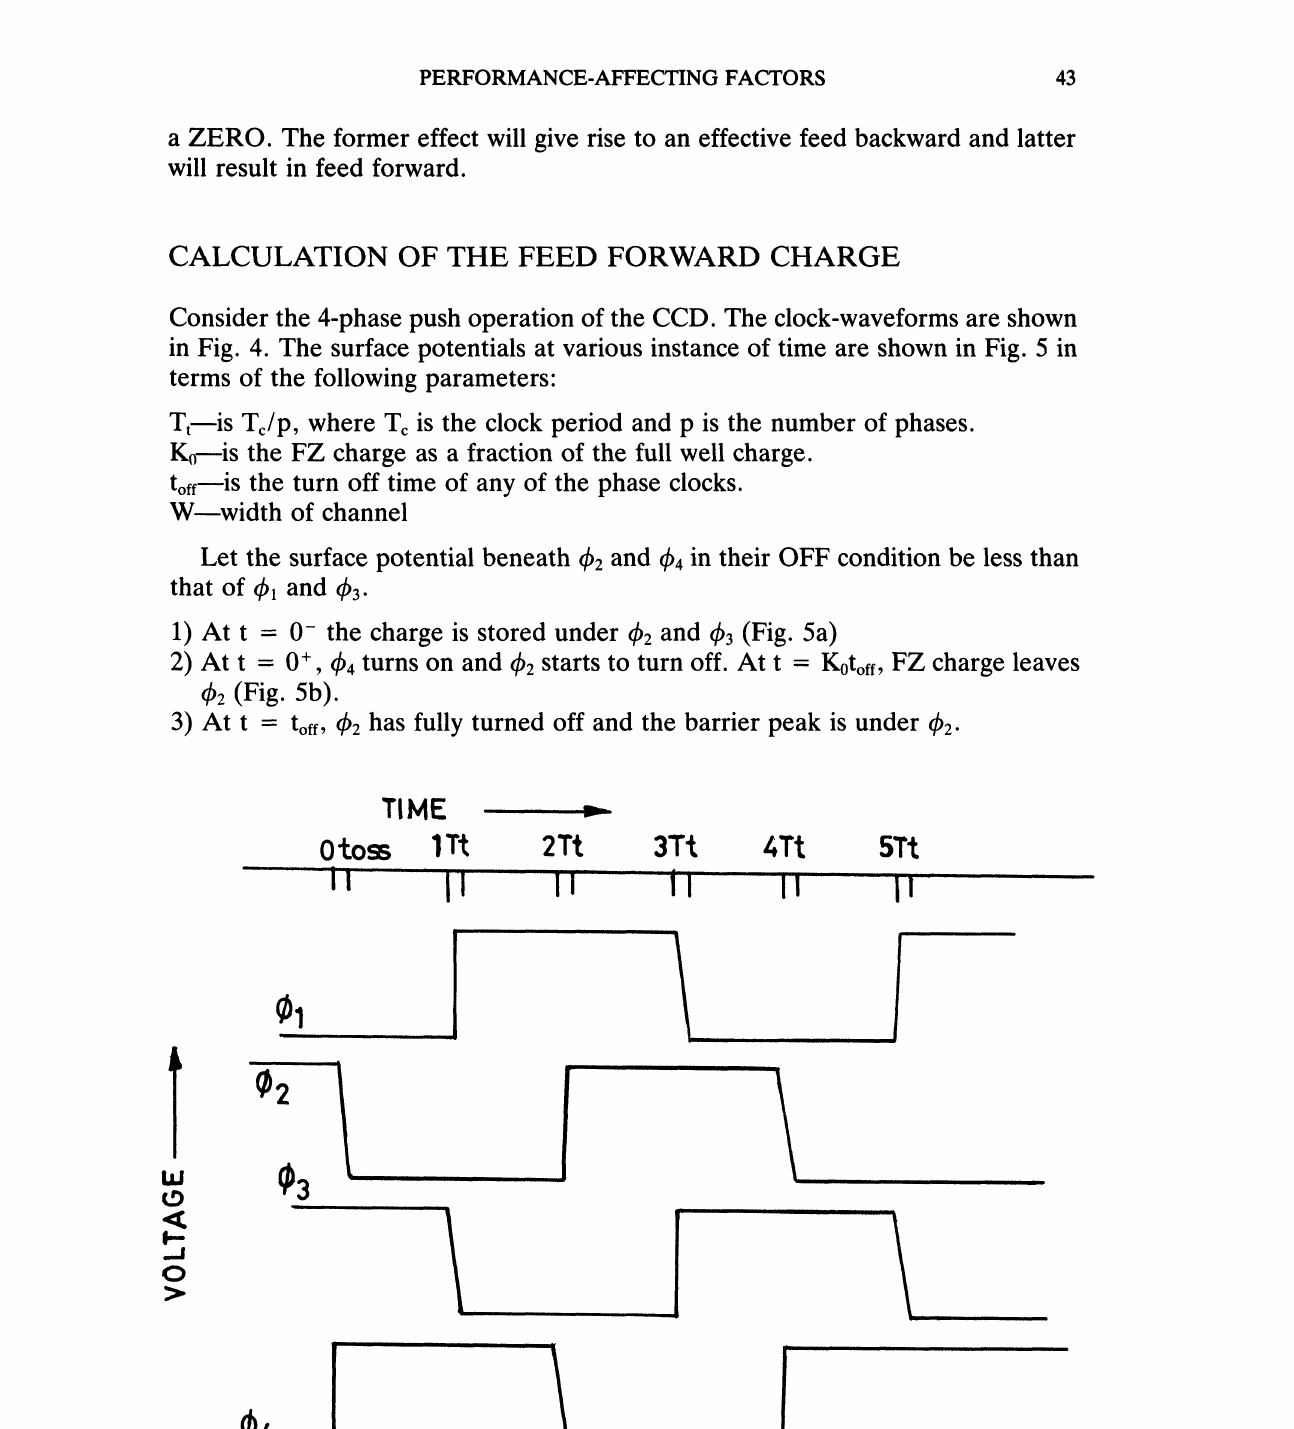
FIGURE 4 Clock waveforms4